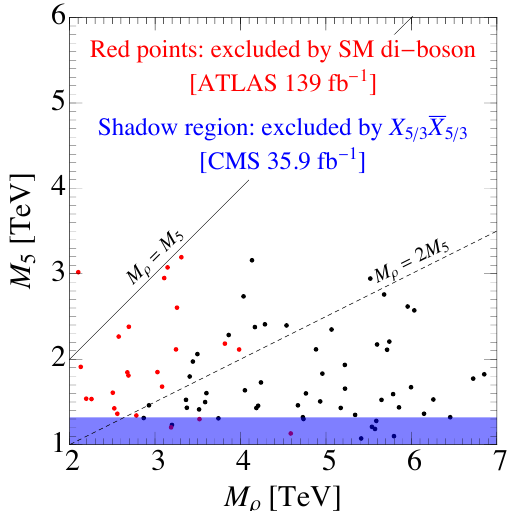
Figure 4 . The collider phenomenology of the parameter points with SFOEWPT. The SM di-boson bound comes from ref. [83], while the X